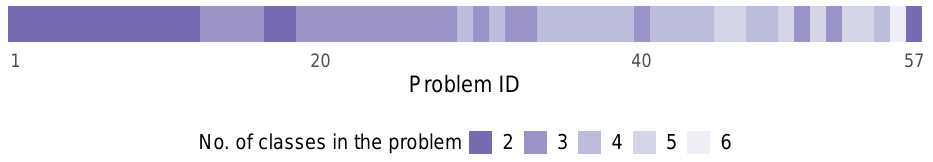
Figure 3. The numbers of classes that were present in the problems, which were labeled and sorted according to increasing levels of hardness. The classification problems that involved more classes tended to be harder, with some